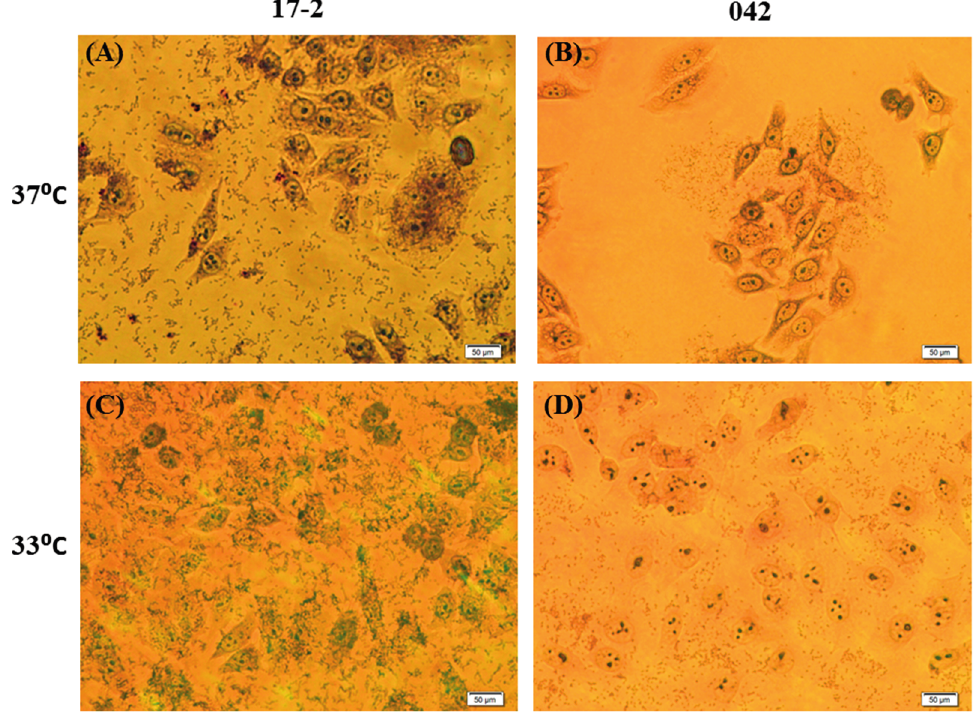
Figure 3. Attachment of EAEC strains 17-2 and 042 to Hep-2 cells in an Adherence assay. ( A ) 17-2 at 37 °C; ( B ) 042 at 37 °C; ( C ) 17-2 at 33 °C; and ( D ) 042 at 33 °C. Magnification